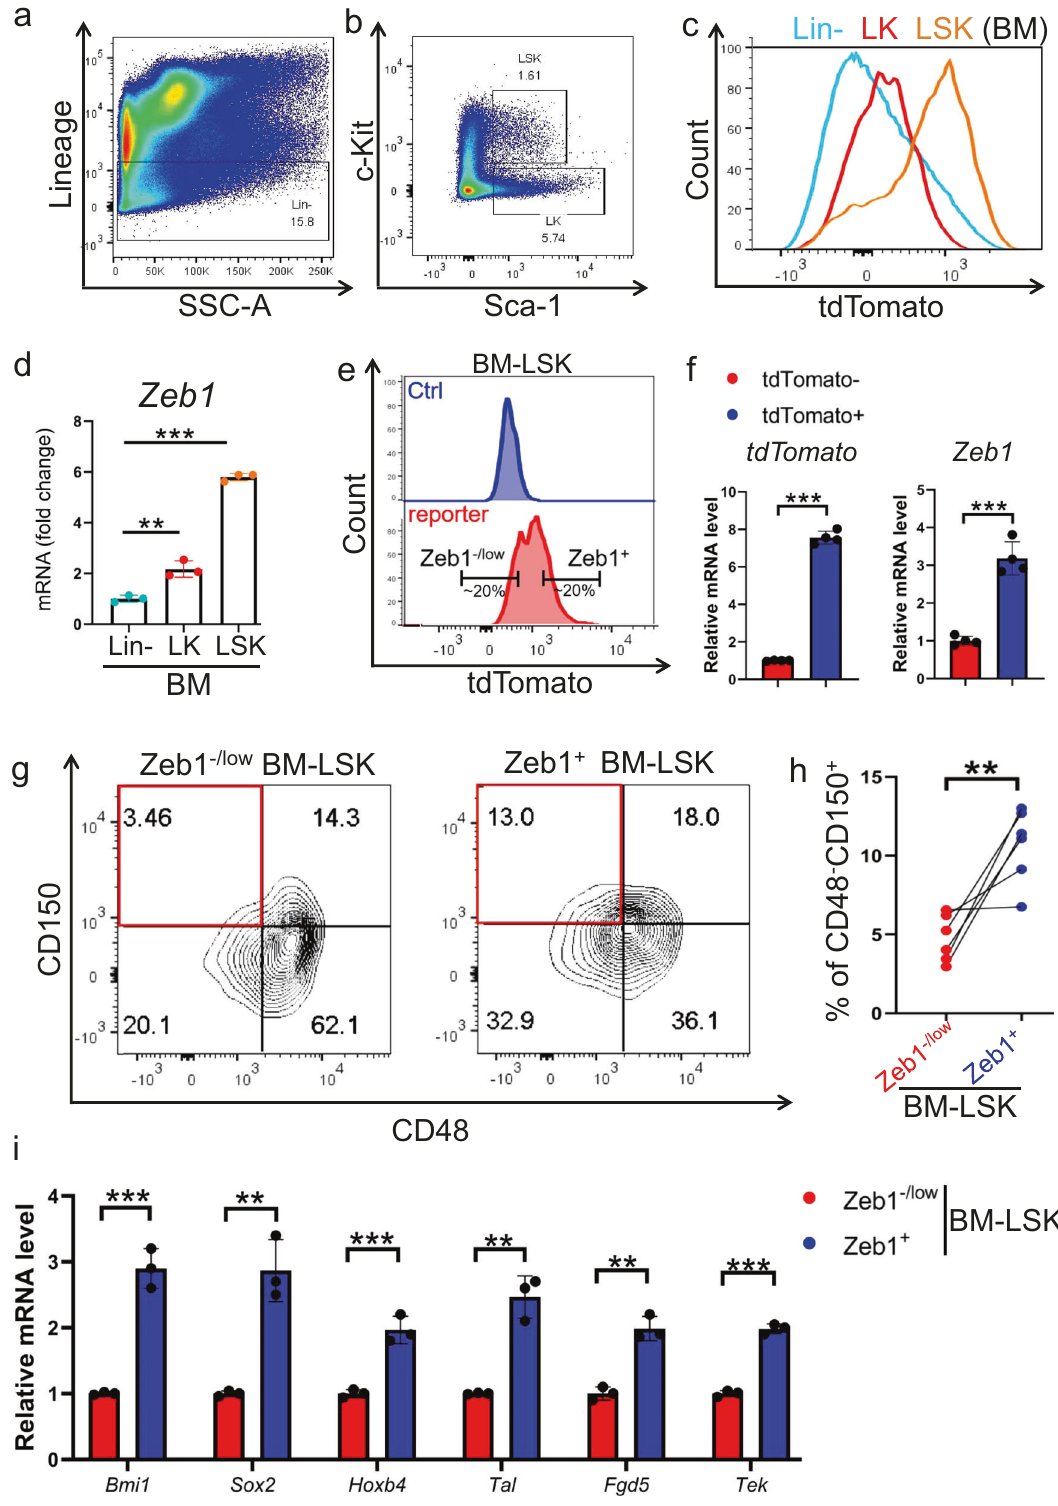
RESULTS Zeb1 is positively associated with stem-cell signature in the hematopoietic system To explore the biological relevance of Zeb1 expression in